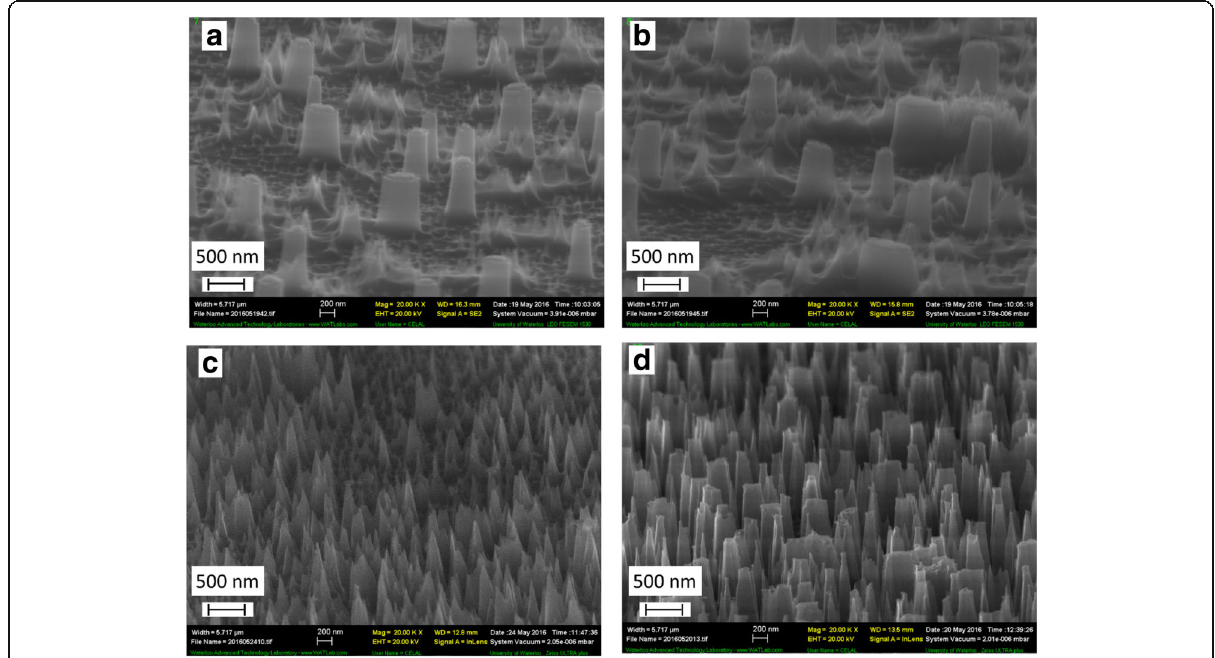
Fig. 5 SEM images of silicon nanopillars formed upon RIE using our process with chromium nitrate nonahydrate: polymer. Ratio of chromium metal salt: PMMA is a 1:10, b 2:10, c 3:10, and d